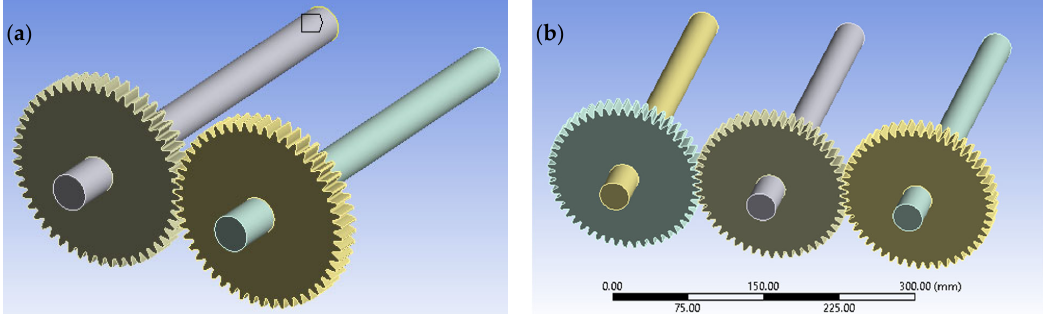
Figure 11. Gears in single tooth region. ( a ) Gear pair. ( b ) Torque split model.